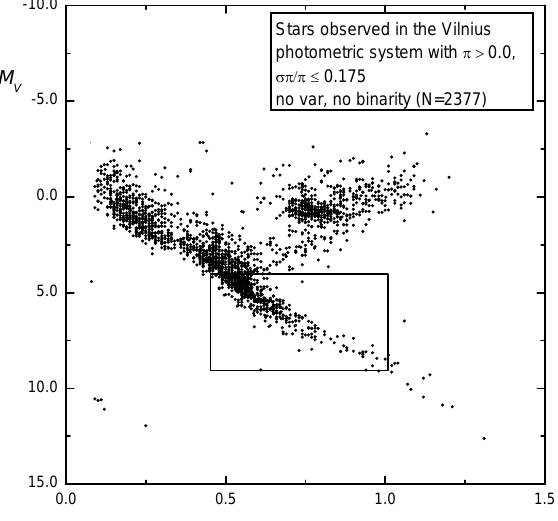
Fig. 2. Selection of stars for M V calibration of dwarfs and subdwarfs in the Vilnius photometric